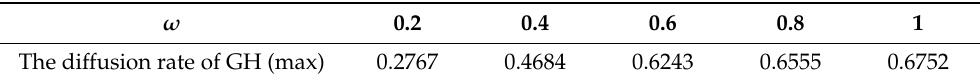
Figure 3. The effect of enterprises subsidy on GH diffusion (Unit: CNY). Table 4. The diffusion rate of GH at different ω